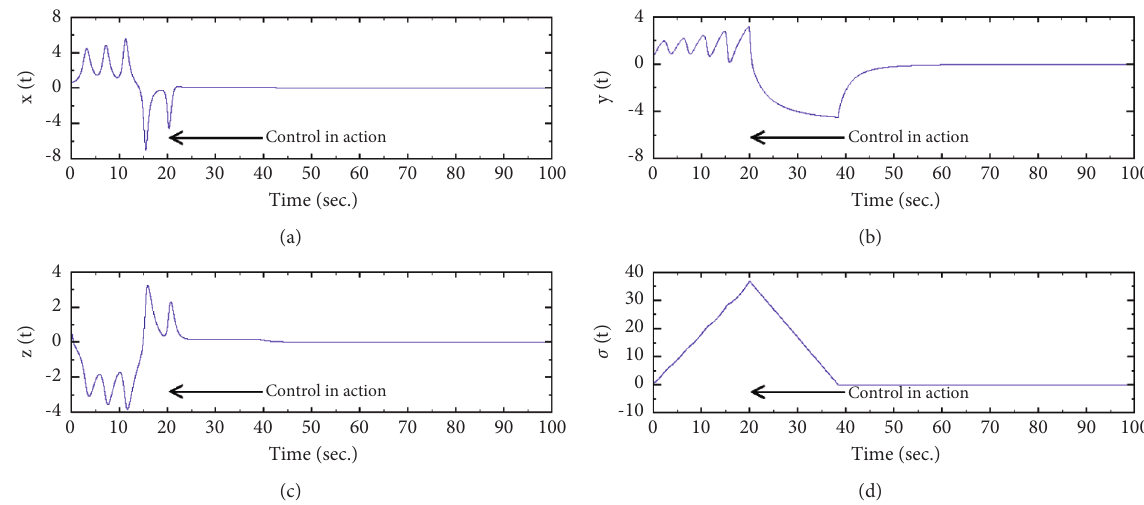
Figure 11: The time series of the controlled commensurate fractional-order system state variables and corresponding time series of the sliding surface without uncertainty and external disturbance (the control input is activated at t � 20 sec).